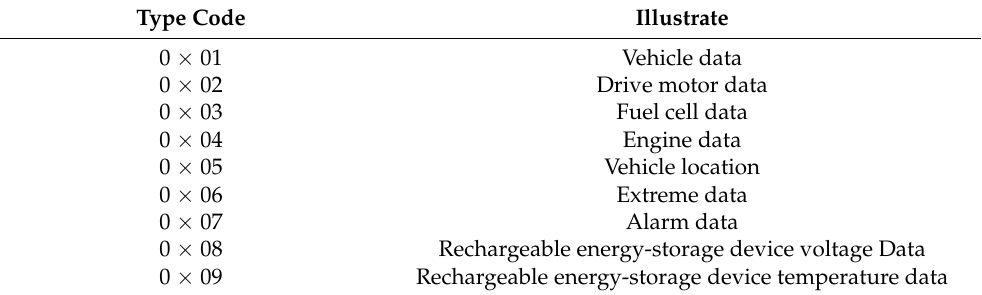
Table 3. Sign of information type.